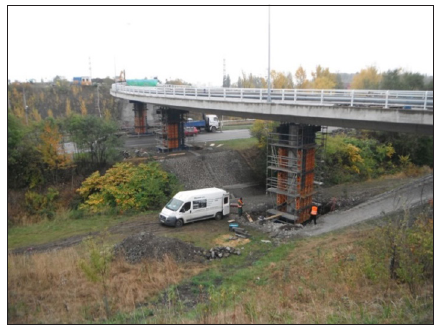
Figure 6. Uplifting a bridge using